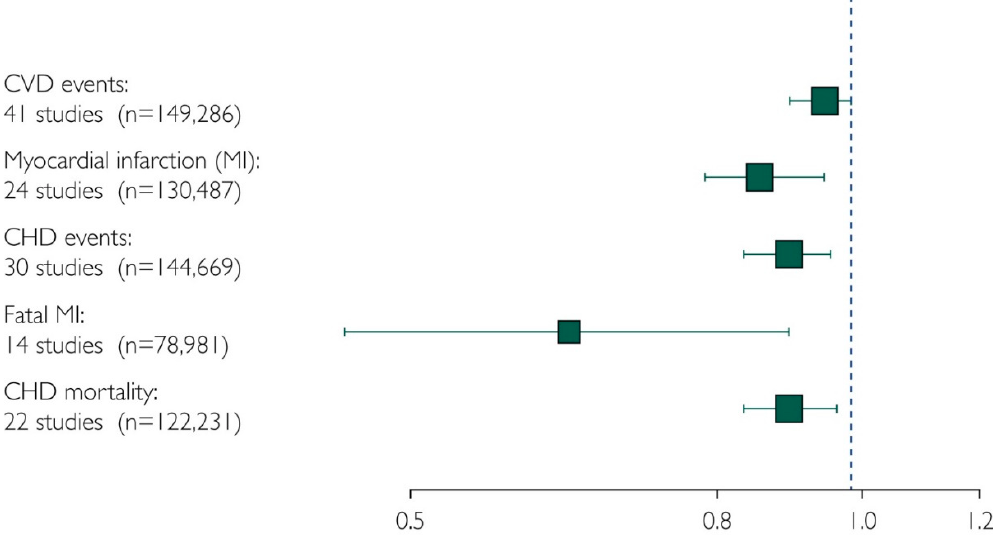
Figure 4. Pooled results from a meta-analysis. Pooled estimate of relative risk and 95% confidence interval, number of studies, and the combined number of participants. CHD, coronary heart disease; CVD, cardiovascular disease; MI, myocardial infarction [52].